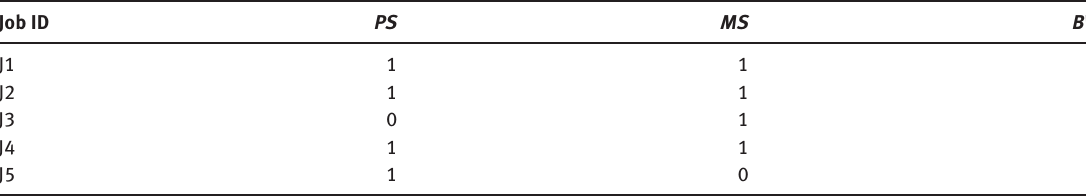
Table 1: Job Requirement Description.